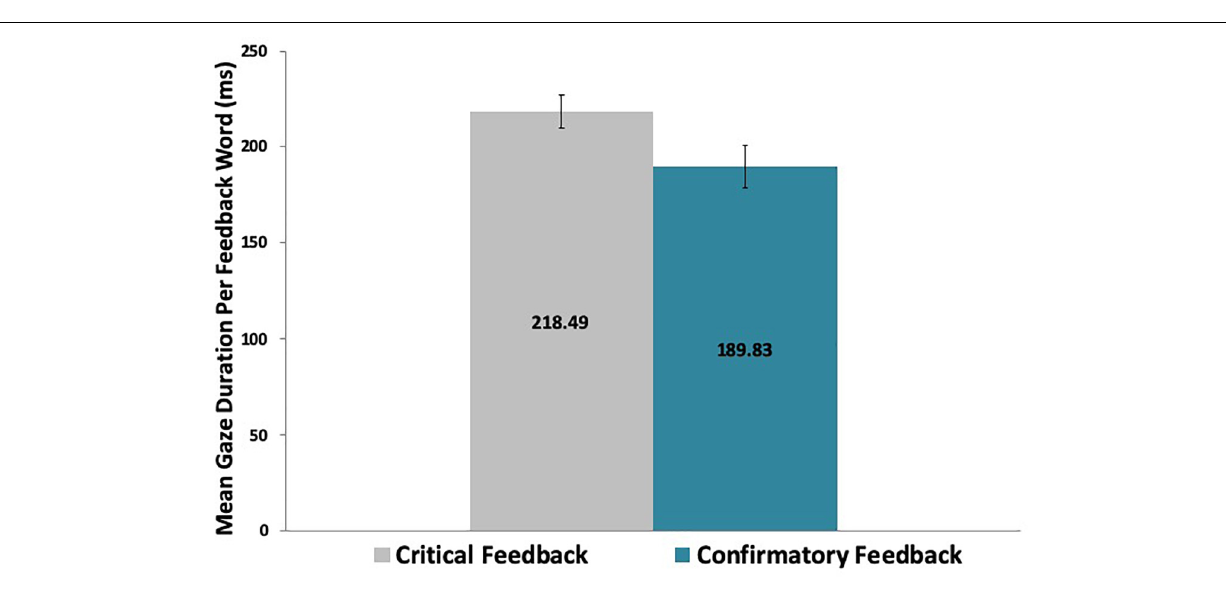
on confirmatory feedback per letter (M = 0.13, SD = 0.04).